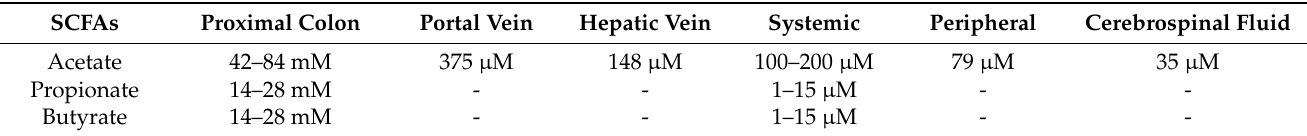
Table 1. Gradient concentrations of SCFAs between gut lumen and periphery.